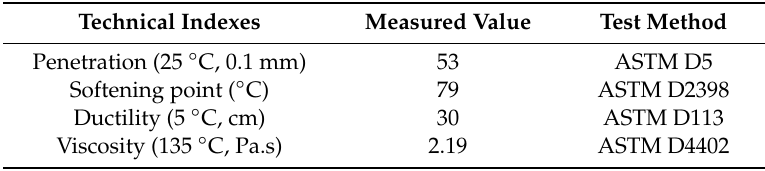
Table 3. Performance parameters of SBS modified asphalt (virgin).